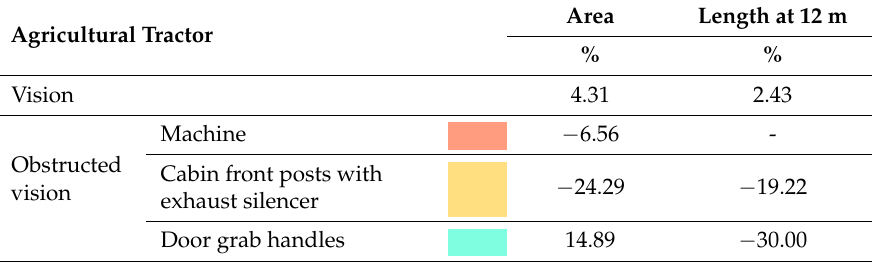
Table 4. Changes in the determination of area and length in the driver’s semi-circular field of vision established by using the TLS method as compared with the method of shadow images cast by point light